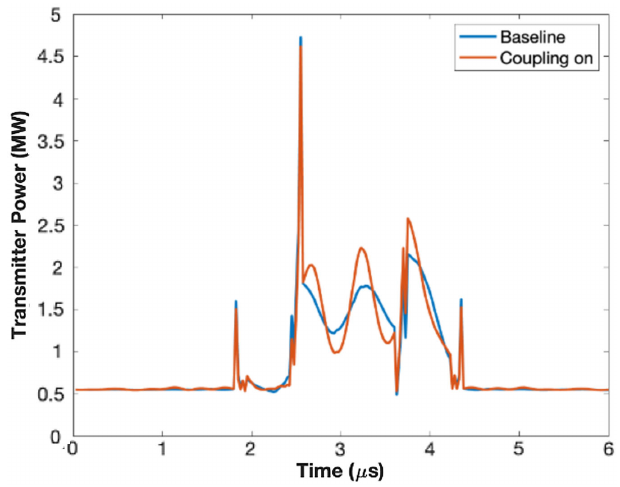
FIG. 17. Transmitter power for four-section cavity with coupled